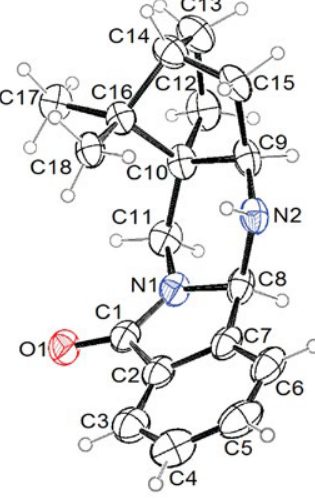
Figure 2. Ortep 28 drawing of asymmetric unit of compound 6 . Dis- placement ellipsoids are drawn with 25% probability level and the hydrogen atoms are shown as small spheres of arbitrary radii.